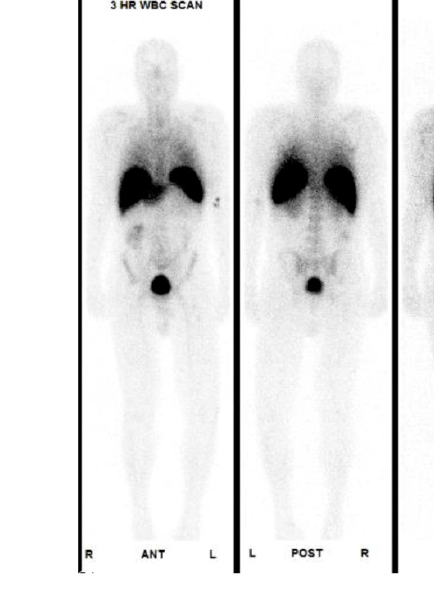
Figure 1. Tagged WBC